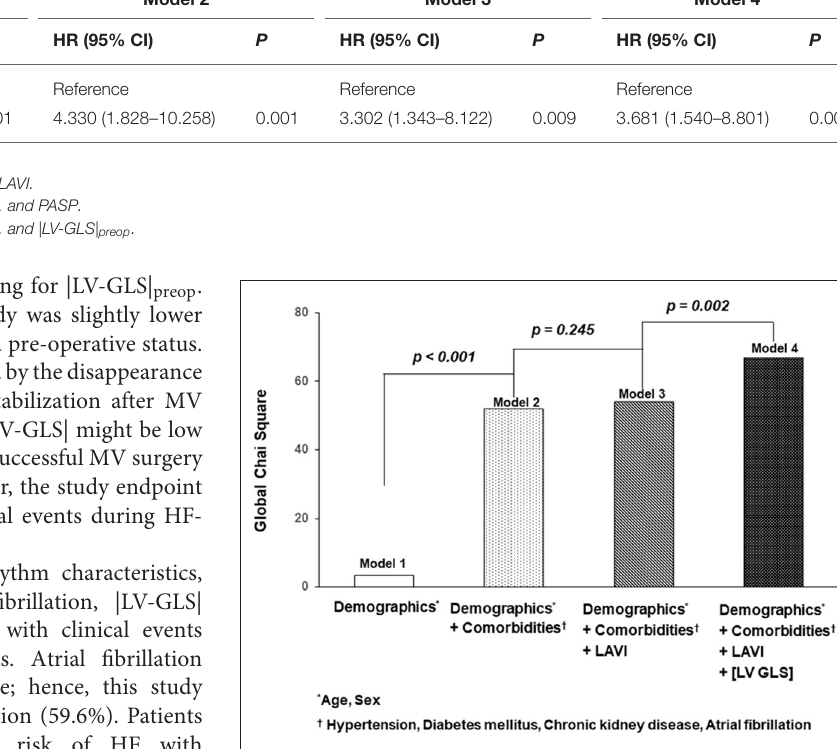
FIGURE 4 | Incremental value of |LV-GLS|. The graphs show the incremental value of |LV-GLS| according to demographics, clinical factors, and LAVI. |LV-GLS|, the absolute value of left ventricular longitudinal strain; LAVI, left atrial volume